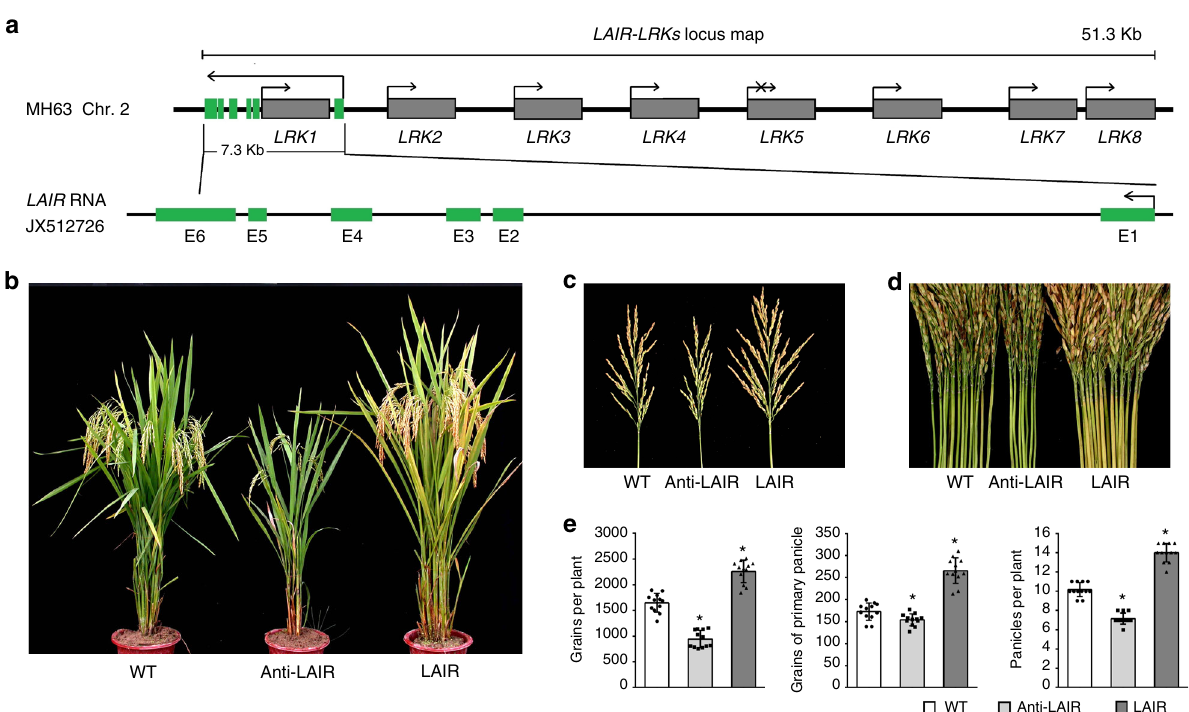
Fig. 1 Cloning and characterization of LAIR . a Genome map of the LRK gene cluster and LAIR . The LRK genes are located in a 51.3-kb region on chromosome 2 of Nipponbare PAC clone AP007224. LncRNA LAIR (JX512726), which includes six exons, is transcribed from the antisense strand of LRK1 . Additionally, LRK1 is in the fi rst LAIR intron, with no overlap between the two transcripts. b – d Phenotypes of wild-type (WT), antisense RNAi- LAIR (Anti-LAIR), and LAIR - overexpressing (LAIR) transgenic rice plants. Growth traits of T 3 transgenic lines were investigated, including mature plant phenotype ( b ), primary panicle size ( c ), and number of panicles per plant ( d ). e Growth traits of Anti-LAIR and LAIR transgenic lines. Student ’ s t -test: * P < 0.05. Data are presented as the mean ± standard deviation ( n =